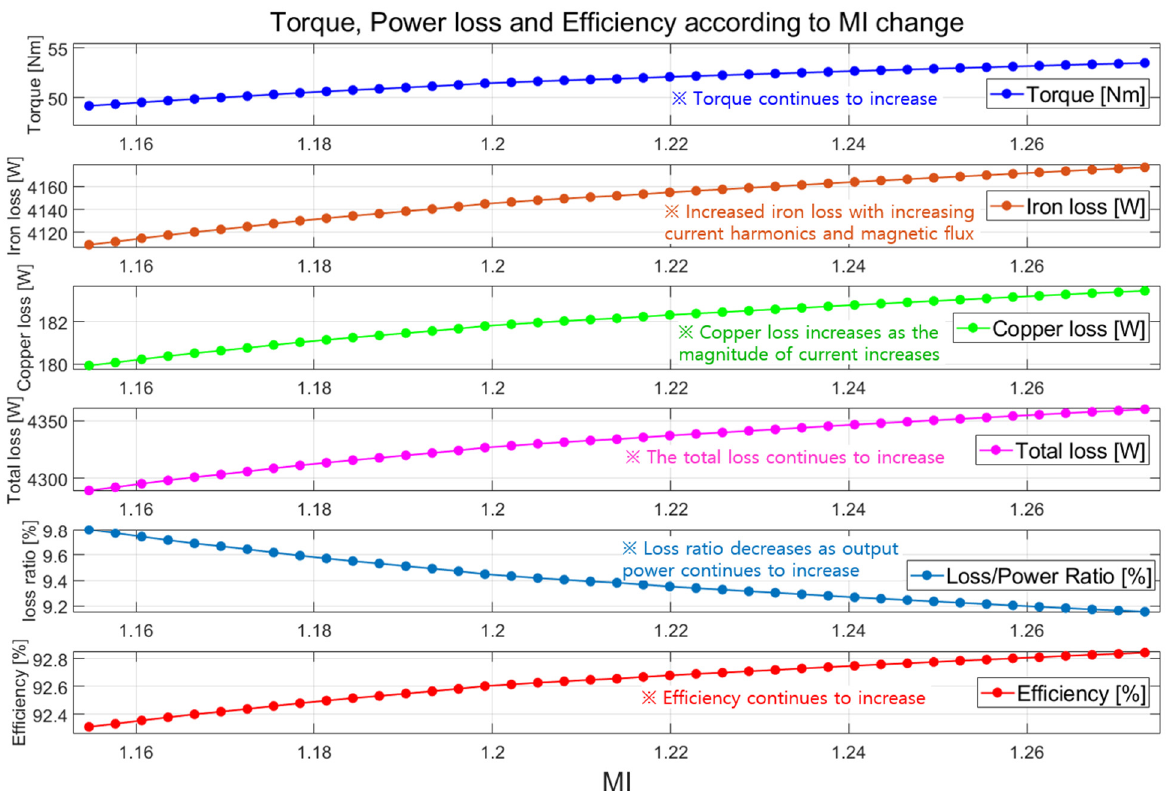
Figure 12. Efficiency change according to overmodulation index change (MFPT).